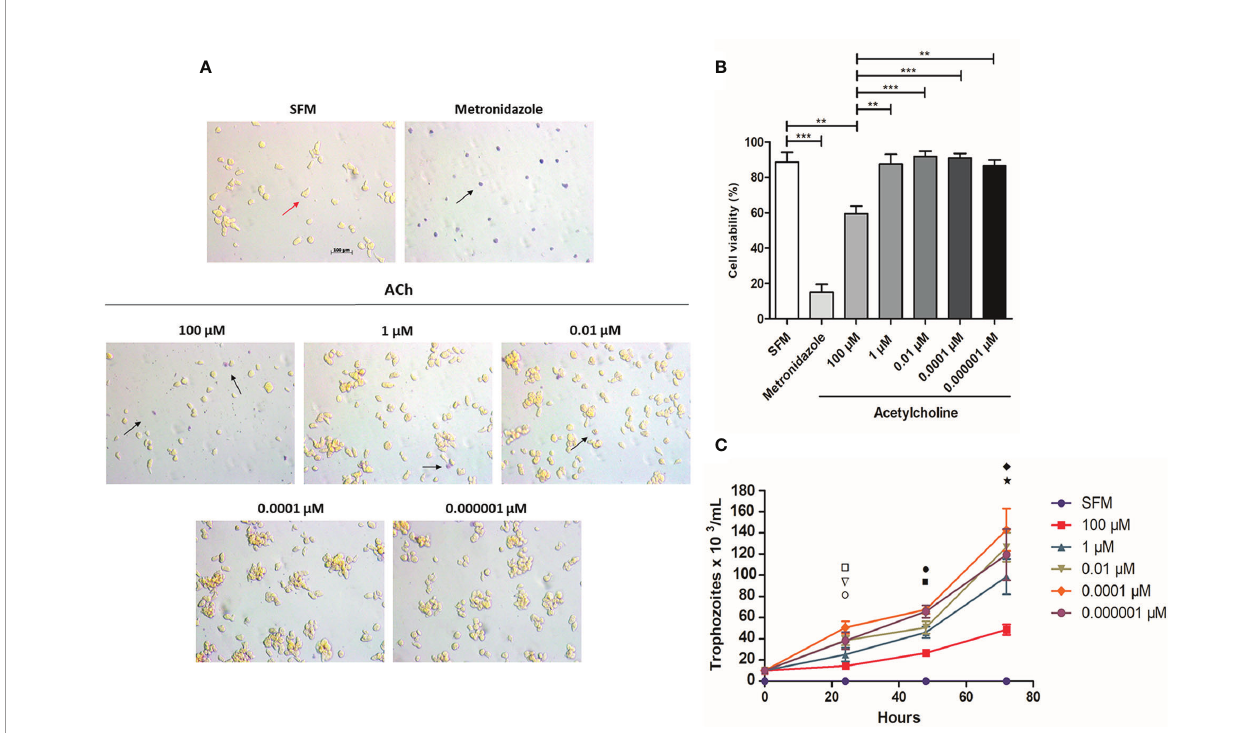
FIGURE 1 | Viability of E. histolytica trophozoites using trypan blue dye exclusion test. (A) Representative images after 1 h ACh treatment with different concentrations (red arrow, viable trophozoites; black arrow, dead trophozoites). (B) Cells viability after 1 h ACh treatment of trophozoites. (C) Proliferation of E. histolytica trophozoites upon ACh treatment. Trophozoites were counted every 24 h. Statistical signi fi cance comparing means pairwise: □ SFM vs 0.0001 µM (**), ▽ 1 µM vs 0.0001 µM (**), ○ 100 µM vs 0.0001 µM (*), ▪ 100 µM vs 0.0001 µM (***), (cid:129) 100 µM vs 0.000001 µM (***), ♦ SFM vs 100 µM (*) and ⋆ 100 µM vs 0.0001 µM (**). Representative images of the analysis by light microscopy at X10 are shown. Data correspond to the mean ± SEM of three independent experiments (n = 3). The statistical analysis was performed with the Kruskal Wallis and Tukey posttest method, where the values of *p < 0.05, **p < 0.01 and ***p < 0.001 were considered signi fi